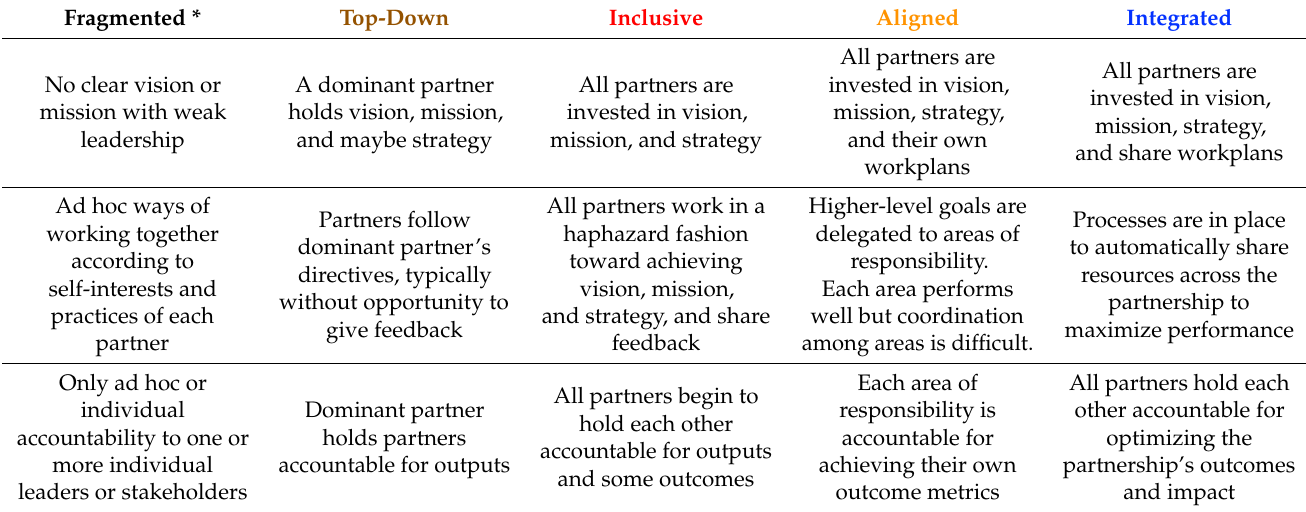
Table 1. Summary of differences between the five cooperative capacity